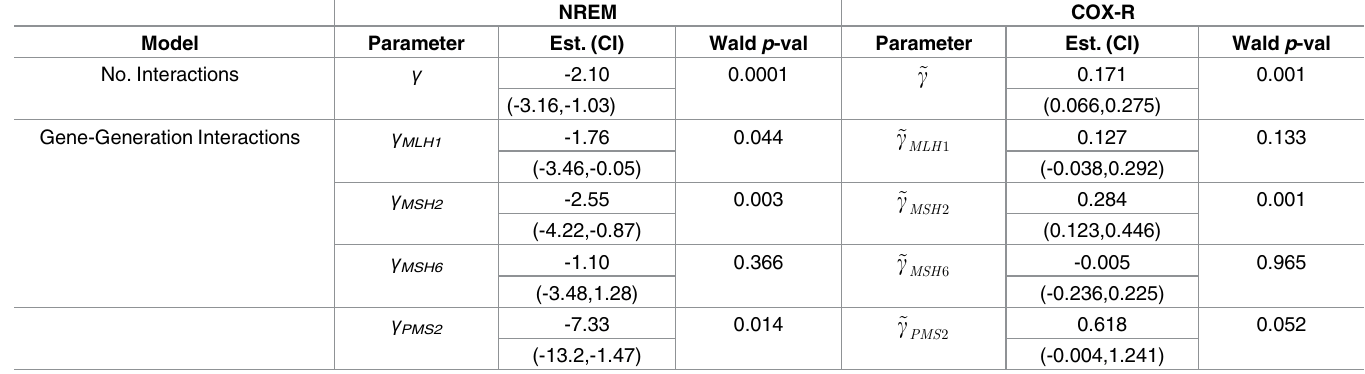
Table 2. Results corresponding to the anticipation effectsfor the NREM and COX-R models, without and with the gene-generation interactions (Est = Estimate, CI = 95% Confidence Interval).